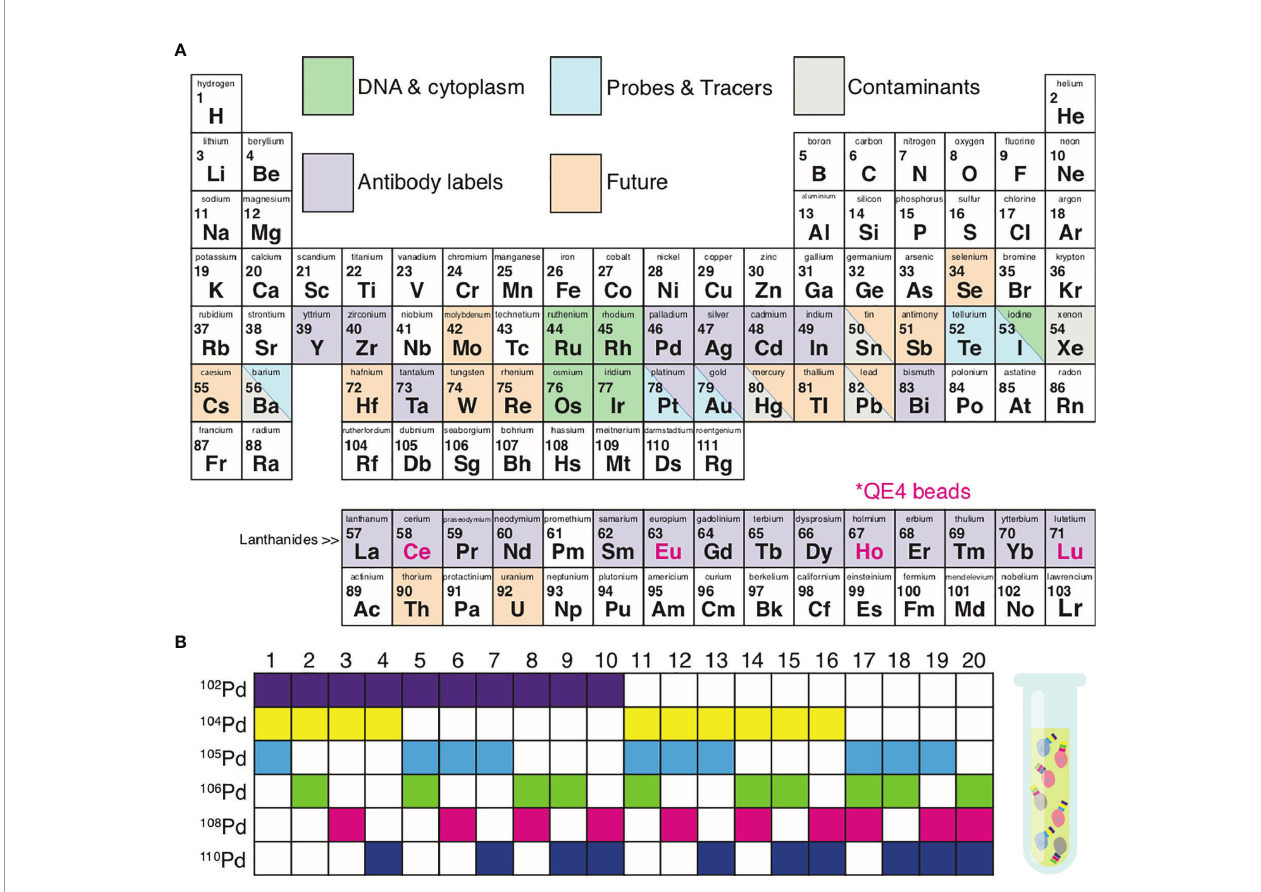
FIGURE 2 | Metal isotopes utilized in mass cytometry. (A) Periodic table summarizing the elements currently available for mass cytometry experiments. Grey , possible contaminating elements; green , elements used to indicate DNA content or cell size; purple , elements available for antibody conjugations; blue , elements available as probes and tracers; orange , elements not yet explored for mass cytometry but of potential future interest. Pink font ; isotopes included in QE4 calibration beads. (B) Certain isotopes work well for the use in sample 1 barcoding. Shown is an example of palladium barcoding using 6 isotopes in unique combinations of 3. This strategy generates 20 separate barcodes, allowing 20 individual samples to be combined into 1 single